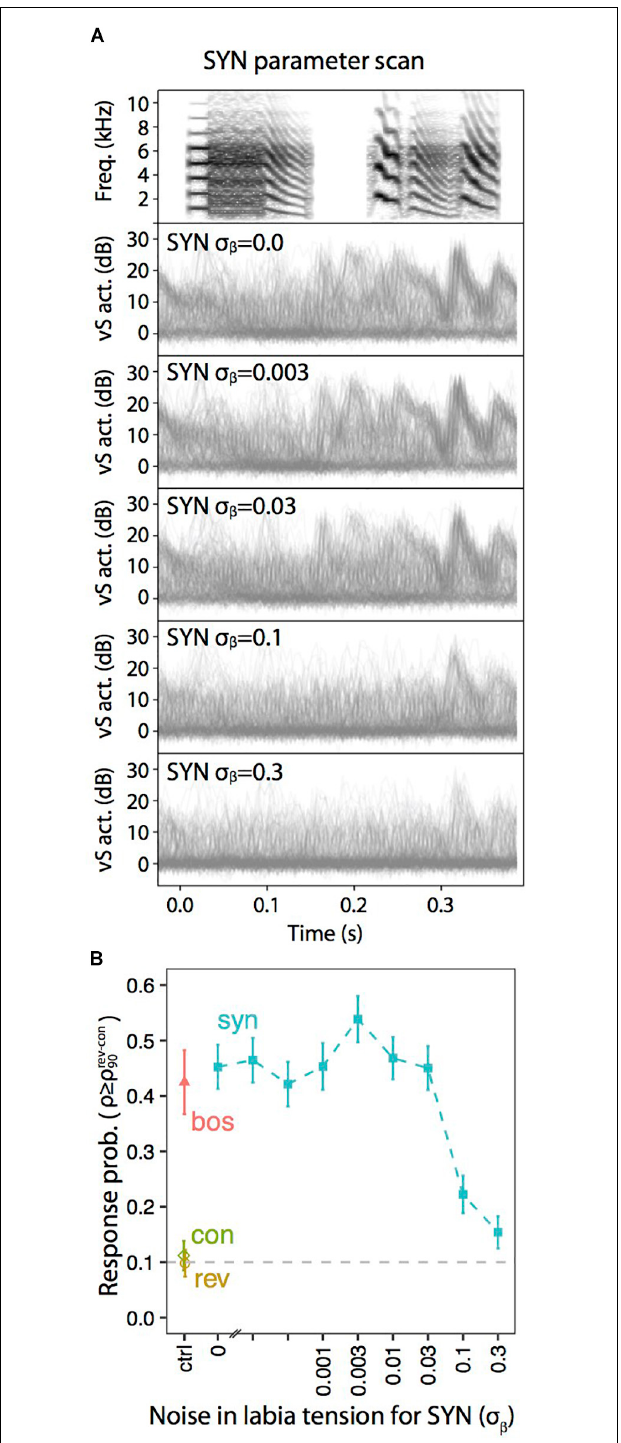
FIGURE 6 | Degraded auditory stimuli evoke motor gestures with lower probability. (A) Overlays of vS activity traces elicited by motifs synthesized with the indicated amount of noise ( σ β ) added to the parameter representing the tension of the labia, β ( t ) . (B) Response probability, calculated as the fraction of playbacks with normalized projection score ( ρ ) higher than the 90th percentile of REV and CON ( ρ REV − CON 90 ). Adapted from Bush et al.